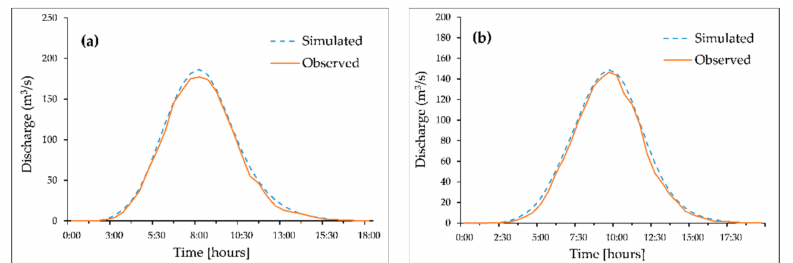
Figure 4. Comparison between the simulated and measured discharge hydrograph: ( a ) calibration and ( b ) validation.